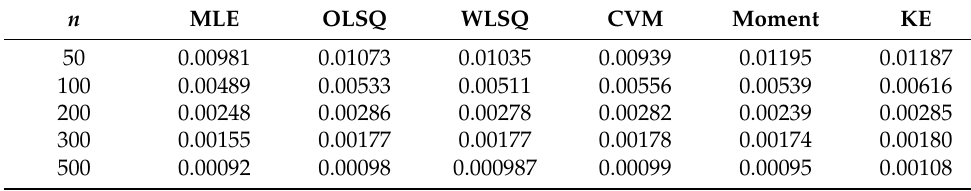
Table 2. Simulation results for δ = 0.9.